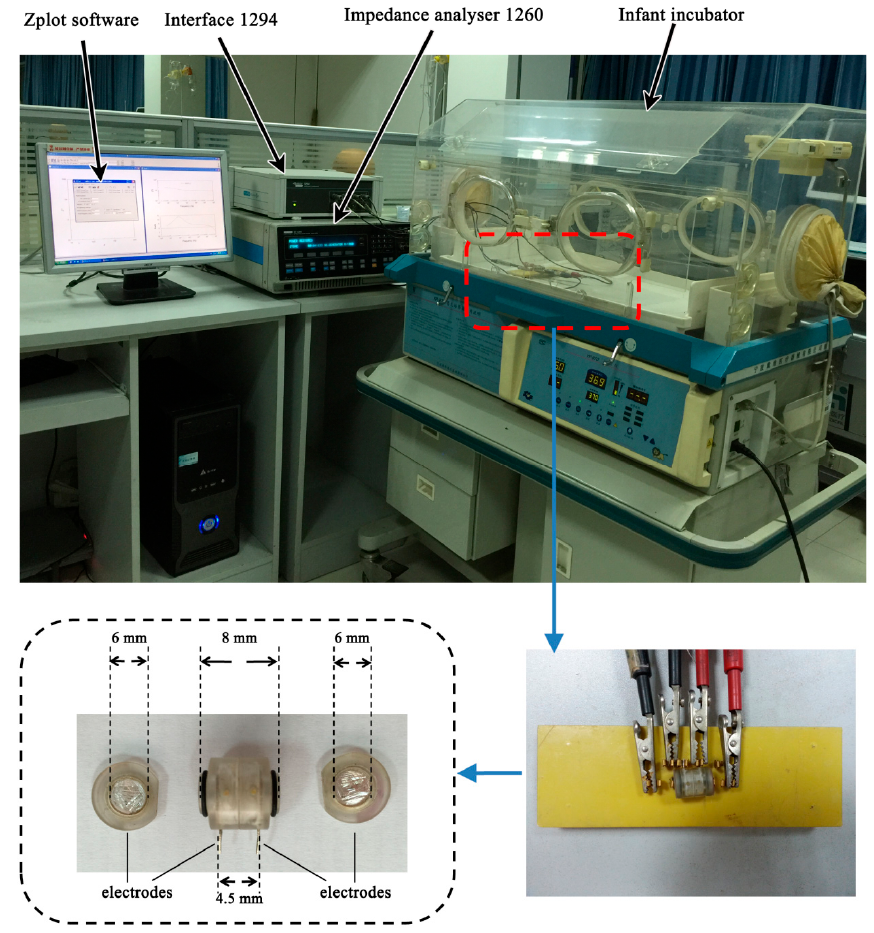
Figure 2. Impedance spectra measurement system including Solartron 1260 impedance/gain-phase analyzer with a 1294A interface and one of the measuring boxes.